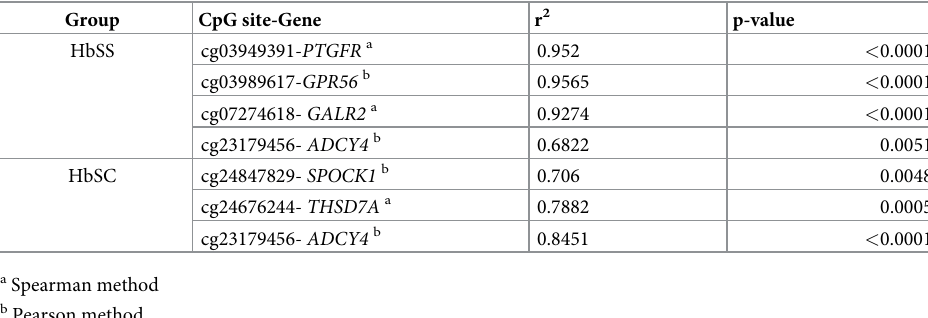
Table 5. Correlation analyses for array and pyrosequencing methylation data.